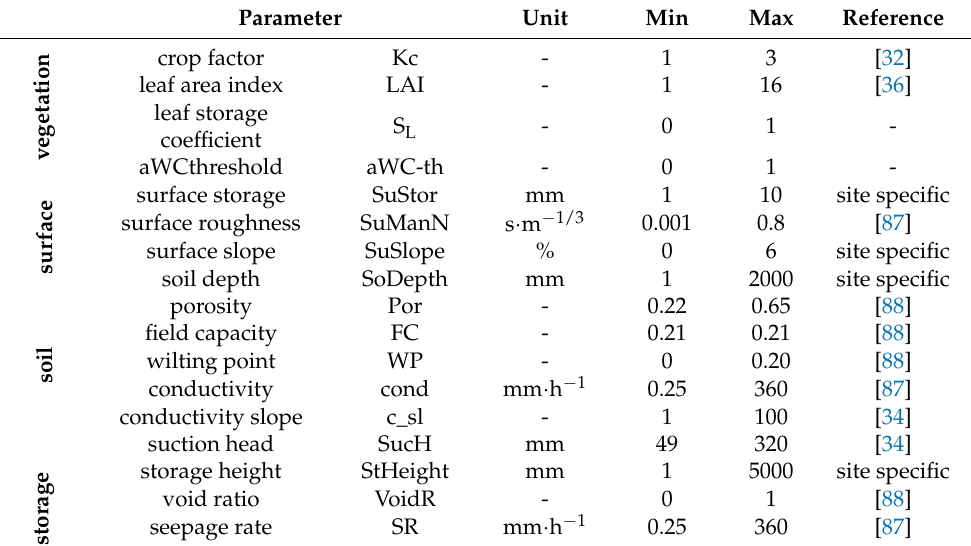
Table 5. LID parameter ranges for sensitivity analysis and model calibration. (grey = fixed parameter, black = varied